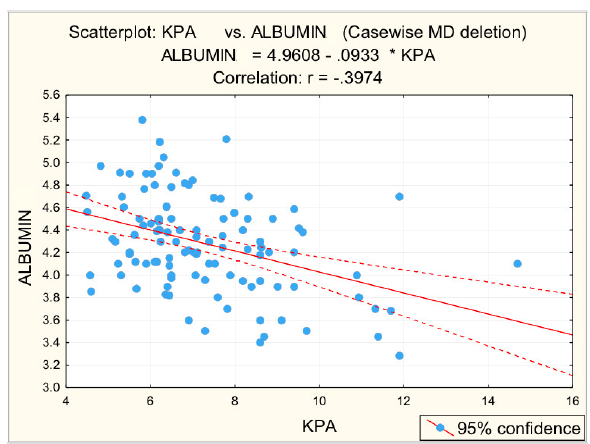
Figure 7. Correlation albumin—fibrosis.